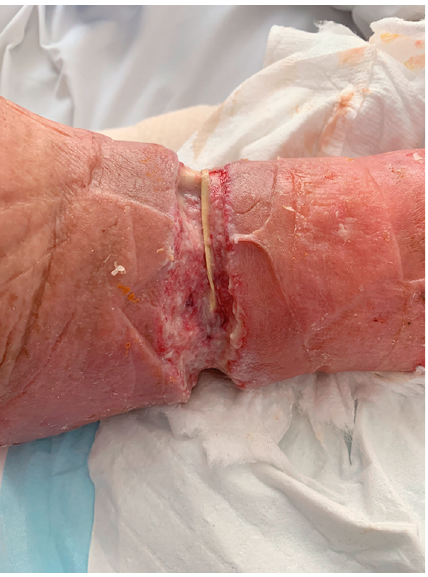
Figure 1: Circumferential leg wound on presentation. Figure 2: Circumferential leg wound after debridement.